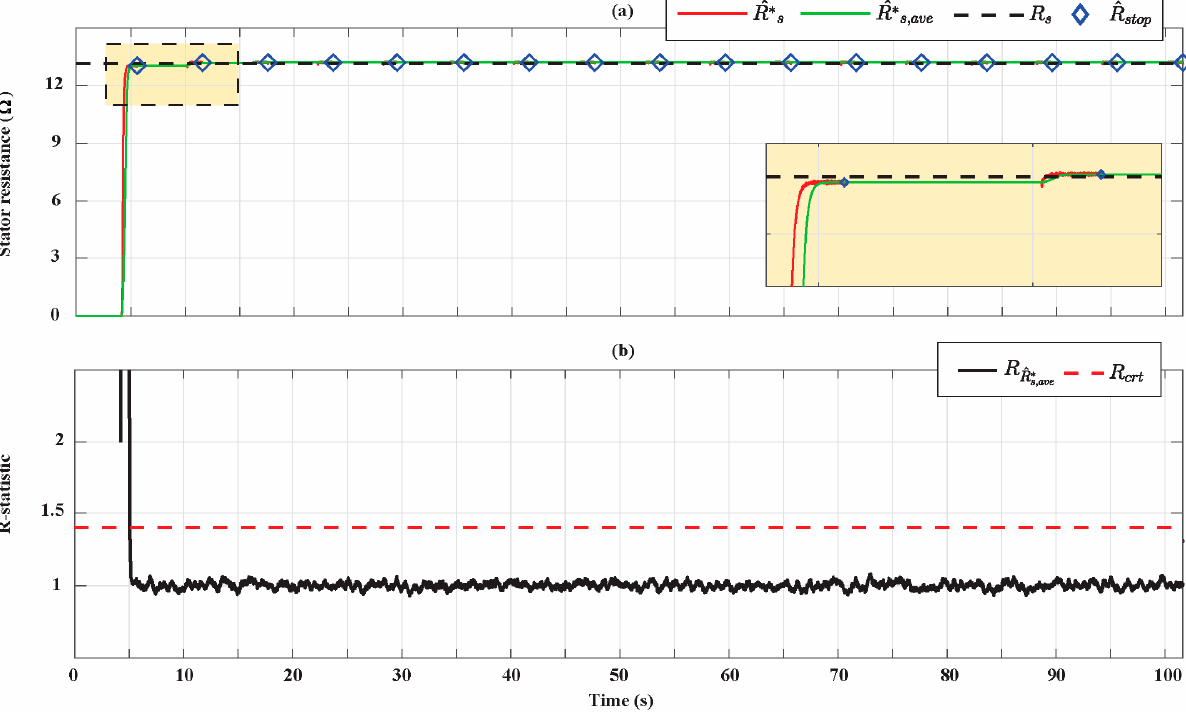
Figure 12. ( a ) Stator inductance estimation for the Bonfiglioli 65; ( b ) R-statistic analysis of the stator inductance estimation.